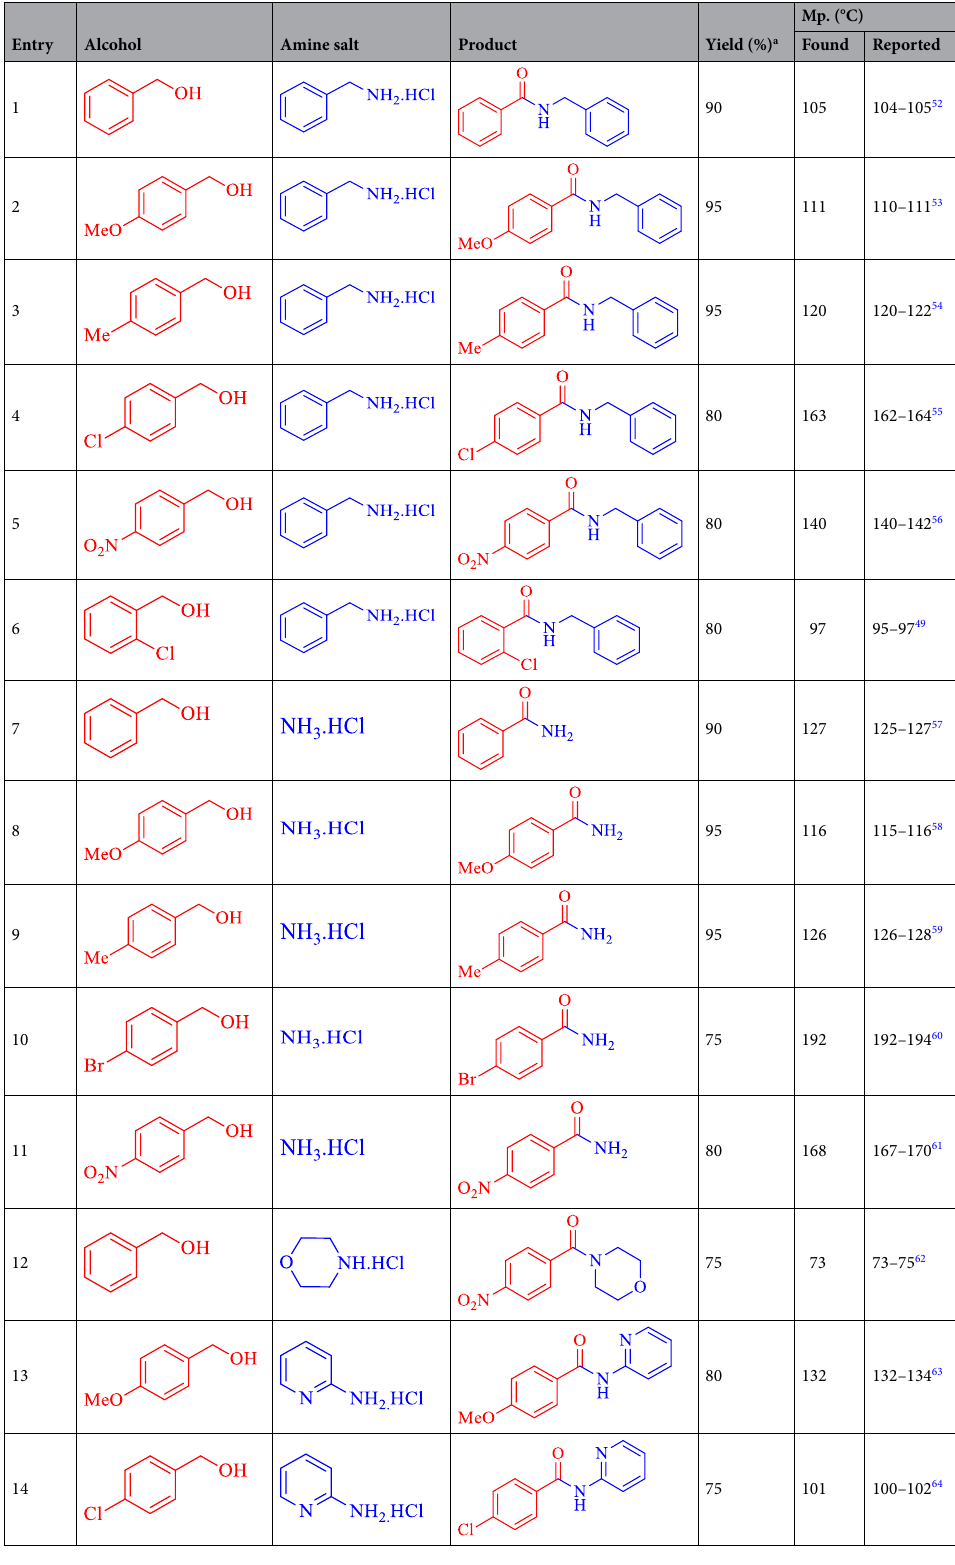
Table 3. Direct oxidative amidation of benzyl alcohols with amine hydrochloride salts. Reaction condition: amine hydrochloride (1.0 mmol), benzyl alcohols (1.5 mmol), catalyst (CN–Pr–Met–Cu(II)) (20 mg), CH 3